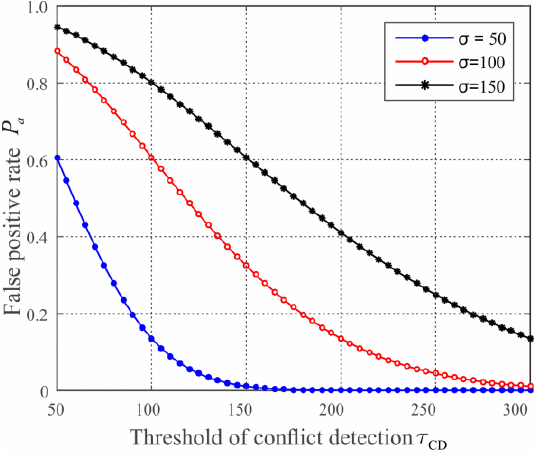
Figure 6. The conflict detection CD vs. false positive rate a P given 50,100,150, respectively.